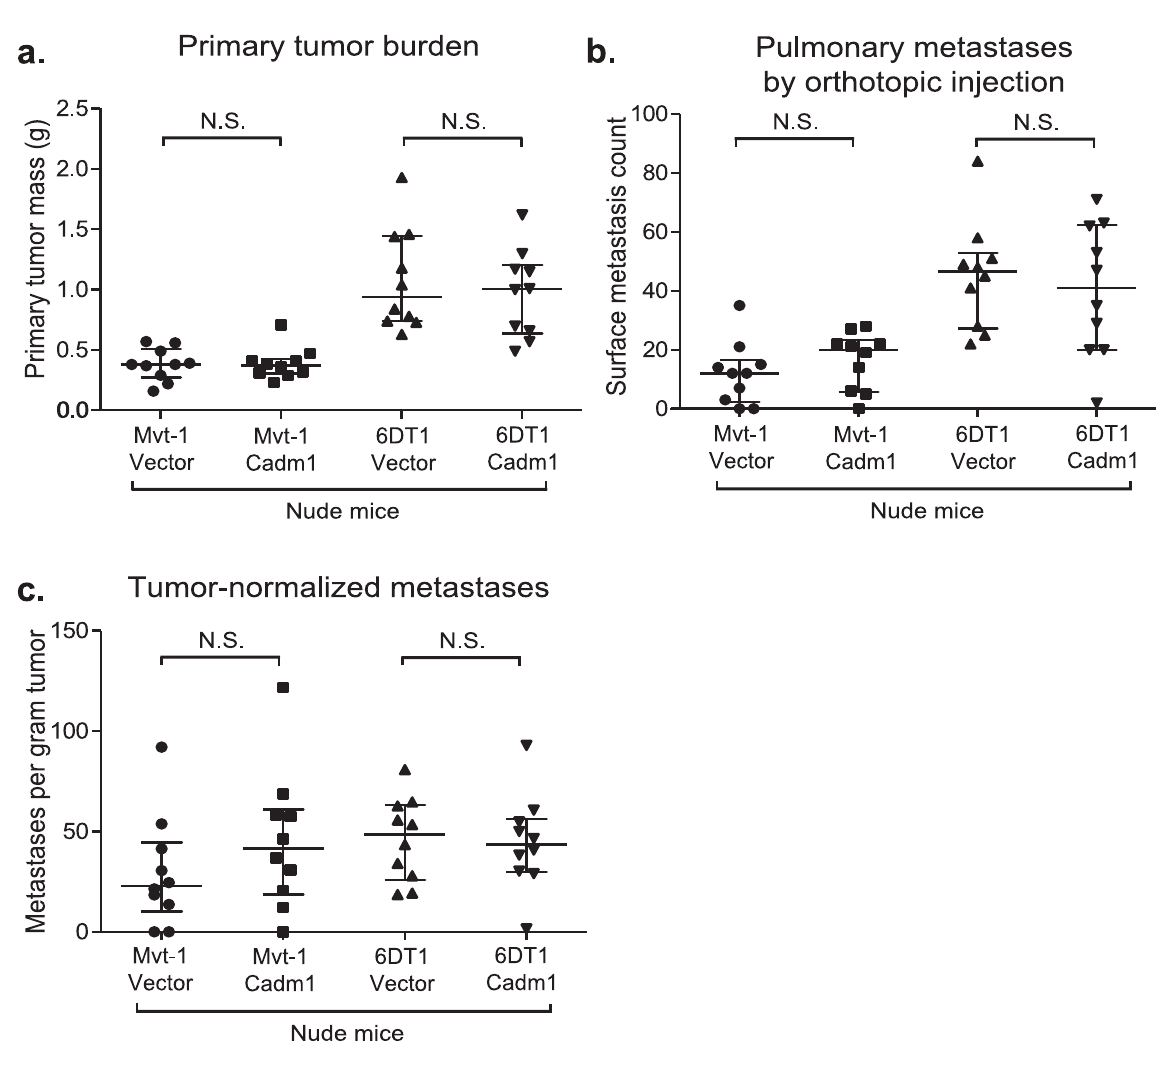
Figure 5. The effect of Cadm1 expression on tumor and metastasis in athymic mice. Orthotopic injections of control and Cadm1 -expressing cells into athymic nude mice resulted in no significant difference in (a) primary tumor burden, (b) pulmonary metastasis, or (c) tumor-normalized metastasis. (median + / 2 interquartile range; n=10 mice per group).